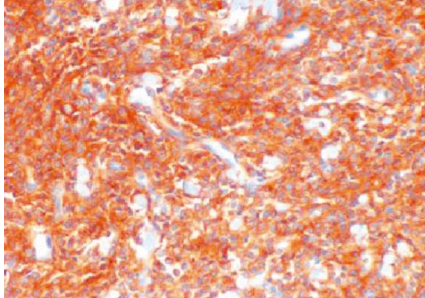
Figure 1: Well-de fi ned lesion, anteromedial to the right external iliac vessels.